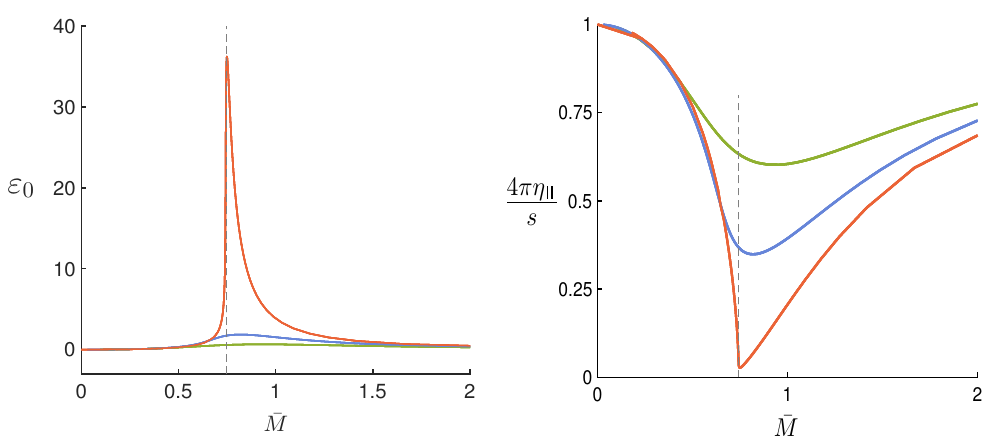
Figure 5. (Left) The anisotropy parameter " 0 evaluated at the horizon for various (cid:22) T = 0 : 1 ; 0 : 05 ; 0 : 005 (from green to orange). (Right) Viscosity to entropy ratio, 4 (cid:25)(cid:17) anisotropic direction for (cid:22) T = 0 : 005 ; 0 : 05 ; 0 : 1. The viscosity is given in terms of the horizon data as p (cid:17) = g 2 ( r 0 ) = h ( r 0 ) [29]. The violation of the KSS bound is evident. On the contrary the ratio k along the isotropic direction saturates exactly the KSS bound 1 = 4 (cid:25) and it is not shown